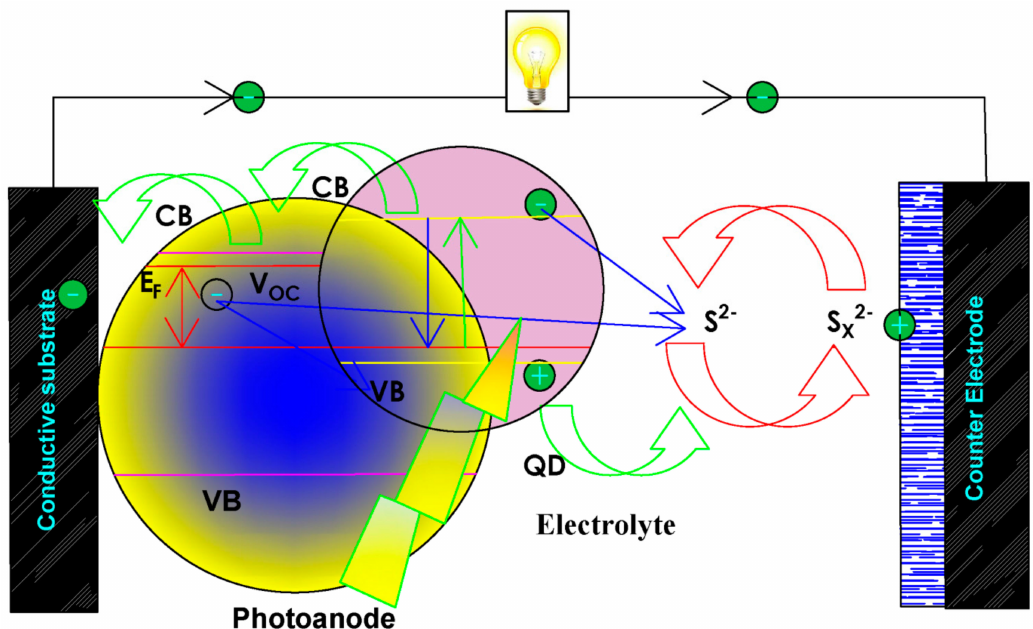
Figure 2. Schematic illustration of the QDSSCs working procedure involving the quantum dot (QD) photosensitizer, counter electrode, photoanode and electrolyte.